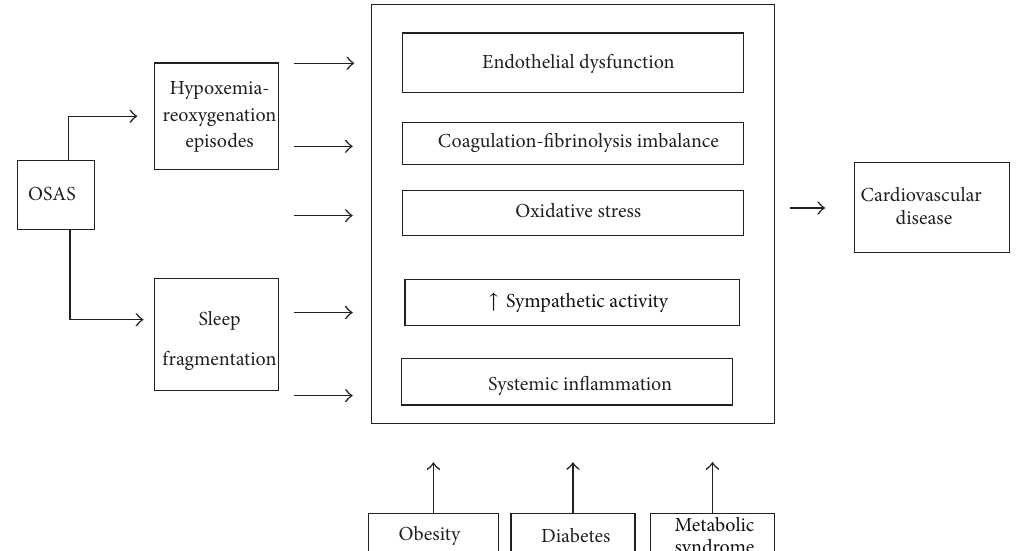
Figure 1: A schematic summary of the proposed sequence of events in obstructive sleep apnea syndrome starting from episodic hypoxia and sleep